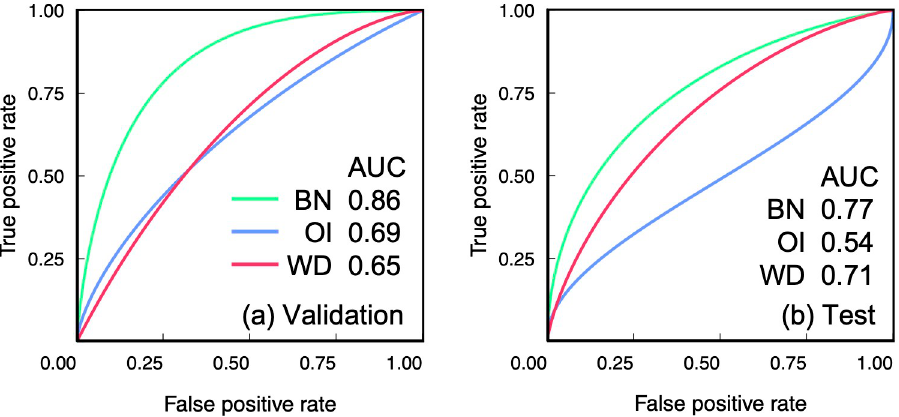
Fig 5. Receiver operating characteristic (ROC) curves for identification of epidermal growth factor receptor mutants using Betti number (BN)-, original image (OI)- and wavelet decomposition (WD)-based models with area under the ROC curves (AUC) in (a) the validation and (b) the test